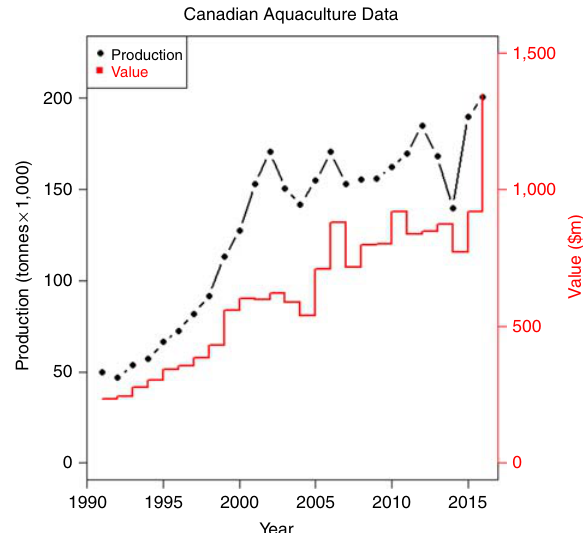
Figure 1. Canadian aquaculture production and value from 1991 to